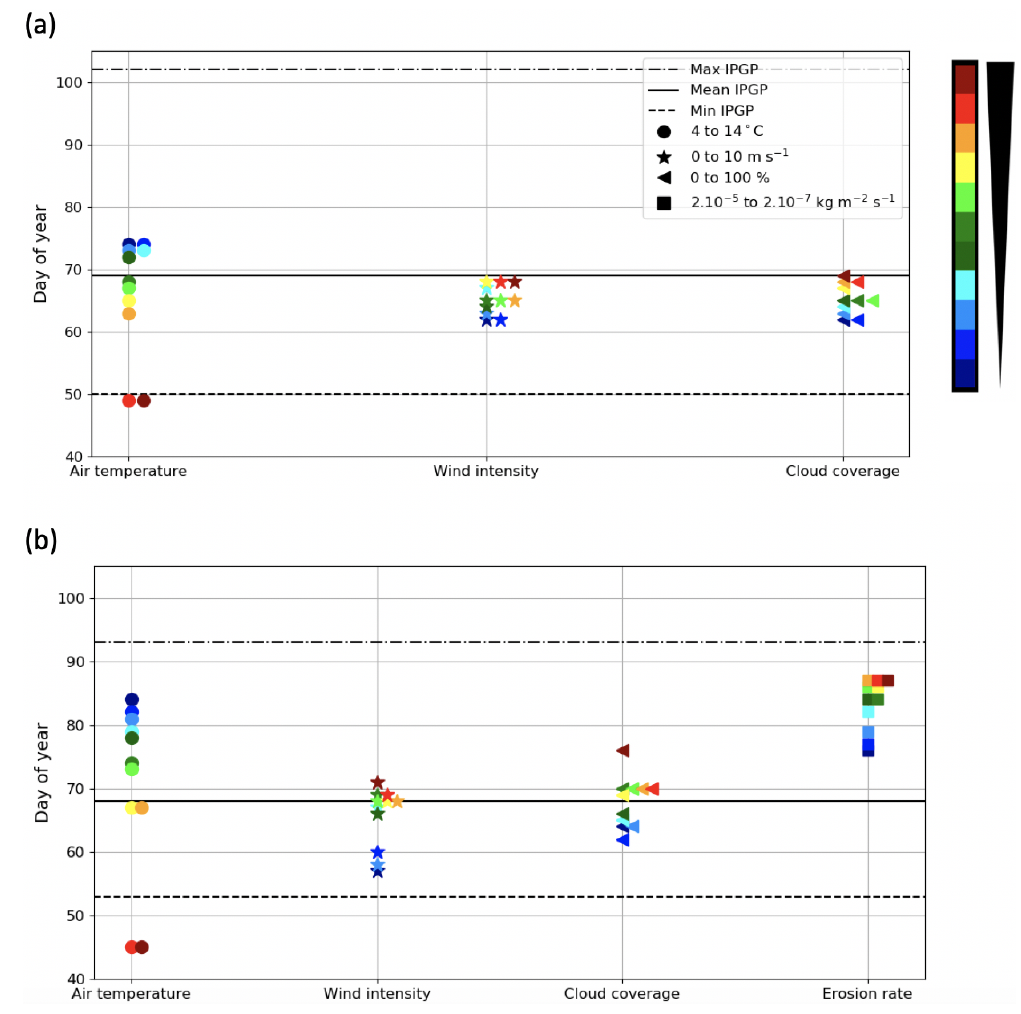
Figure 8. Impact of the variation in environmental drivers on the date of the IPGP in (a) the Bay of Brest and (b) the Bay of Vilaine. Steps of 1 ◦ C for the air temperature, 1ms − 1 for the wind intensity, 10% for the cloud coverage, and 0.0000036kgm − 2 s − 1 for the erosion rate equivalent to a variation in suspended matter between 0.02 and 0.08mgL − 1 at the